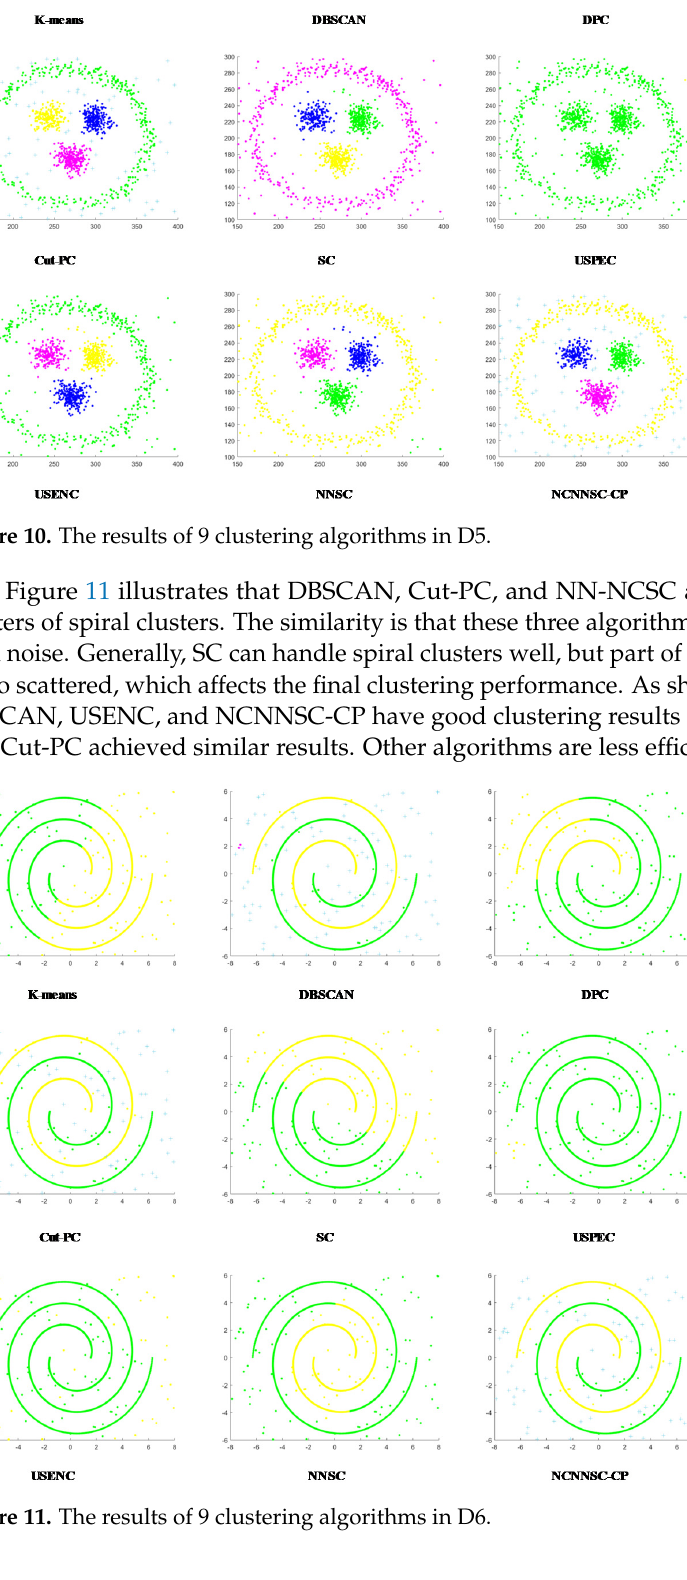
Figure 9. The results of 9 clustering algorithms in D4.